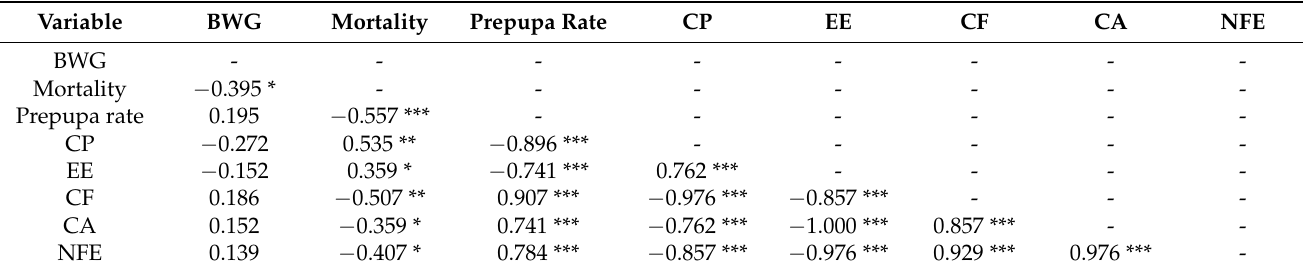
Table 7. Spearman’s correlations in Experiment 2.